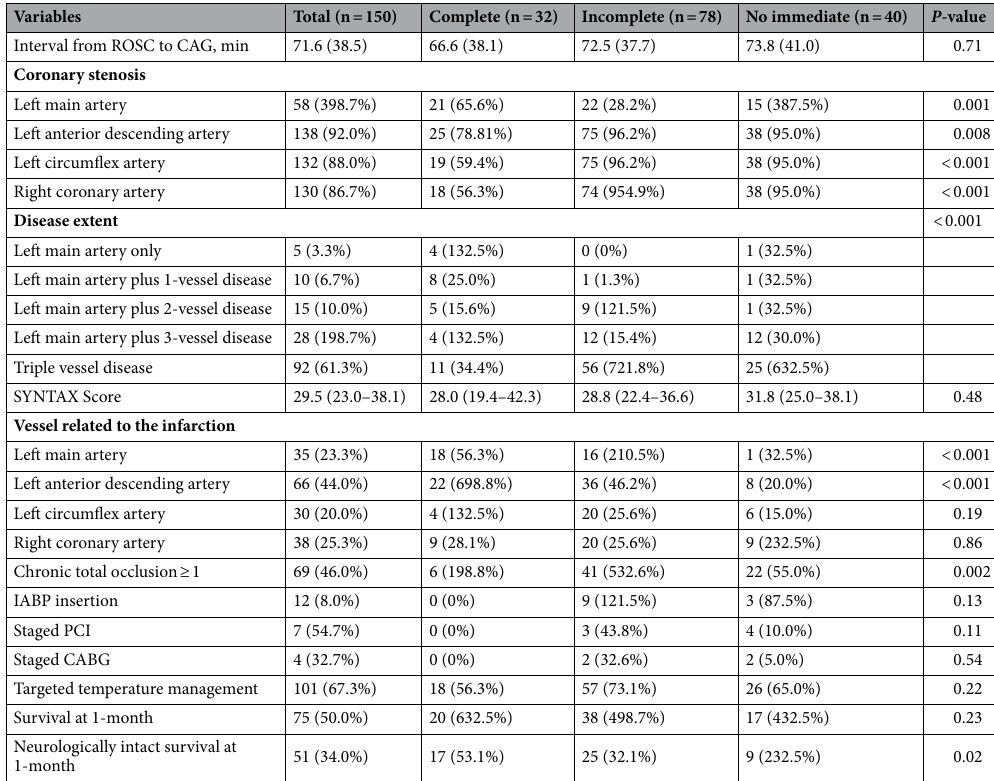
Table 2. Coronary angiographic findings and clinical outcomes according to revascularization strategies. Values are presented as mean (standard deviation), median (interquartile range) or number (percentage). CABG coronary artery bypass grafting, CAG coronary angiography, IABP intra-aortic balloon pump, PCI percutaneous coronary intervention, ROSC return of spontaneous